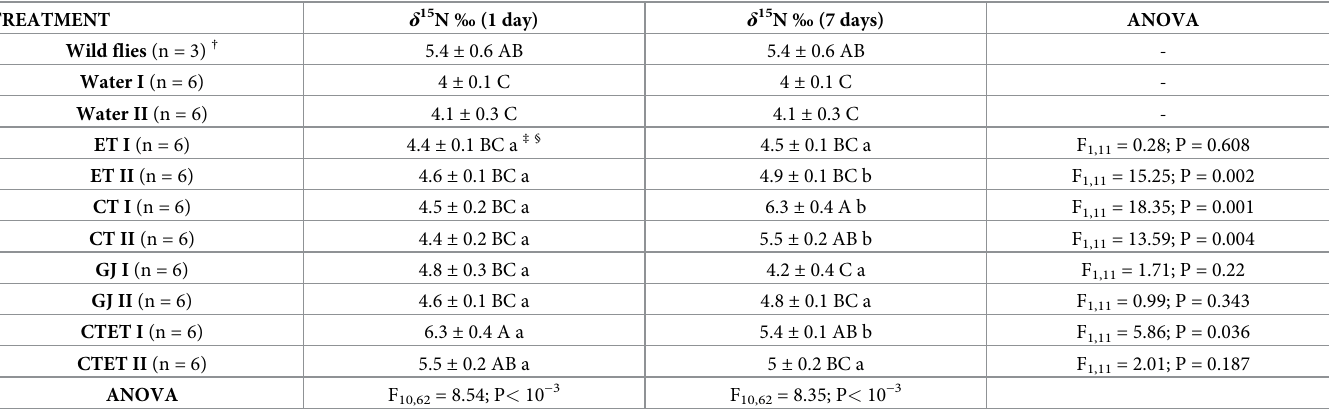
† The mean values of wild flies from the three different apple orchards were considered all together. Acronyms: ET = ethanol; CT = CeraTrap TM ; GJ = grape juice; CTET = CeraTrap TM for 7 days and then flies immersed in absolute ethanol for 7 days; I = performed with flies from Diet I; II = performed with flies from Diet II. ‡ Means ( ± SE) followed by the same uppercase letter in the columns do not differ significantly at the 5% probability level by the Tukey’s test. § Means ( ± SE) followed by the same lowercase letter in the lines do not differ significantly at the 5% probability level by the Student’s t-